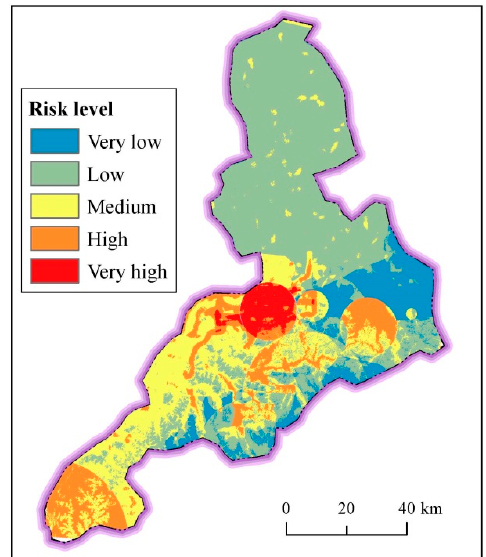
Figure 17. Spatial distribution of risk level in Jinan City. Table 9. Comprehensive statistical risk level in different